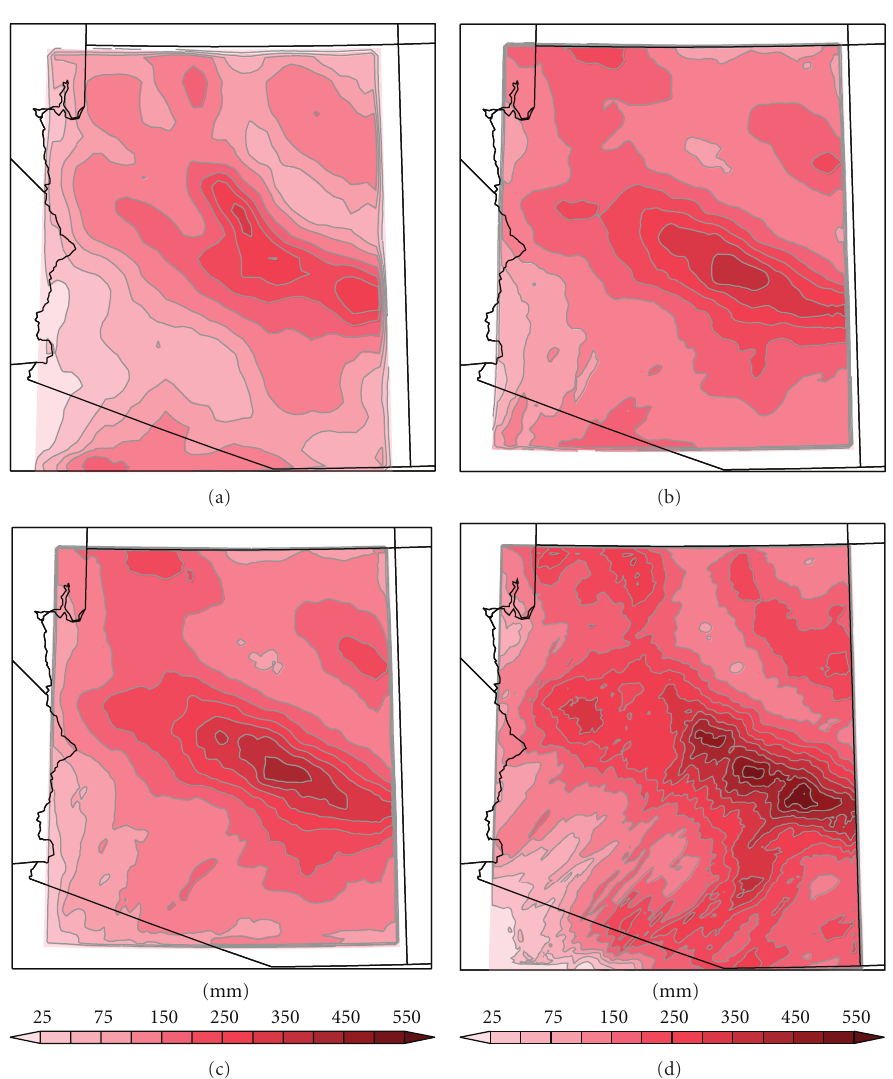
Figure 3: Same as Figure 2 but for di ff erent runs or combinations of variables for rainfall. (a) Total rainfall (RAINC+RAINNC) from the 12km runs. (b) Total rainfall (RAINC+RAINNC) from the 6km runs with cumulus parameterization turned on. (c) Total rainfall (all produced by grid-scale convection, RAINNC) from the 6km runs with cumulus parameterization turned o ff . (d) Total rainfall (RAINNC) from the 3km